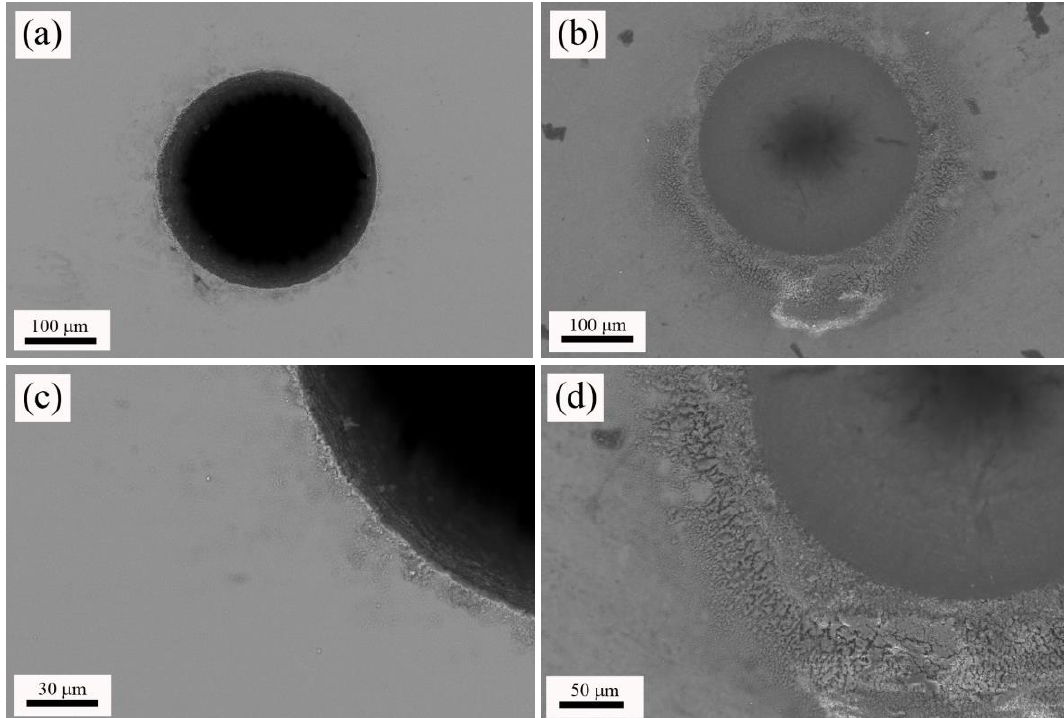
Figure 3. Top-view micrographs of the machined glass ( a ) and glass-ceramic ( b ); and detail of the heat affected zone, HAZ, produced in the surroundings of the processed area in the glass ( c ) and glass-ceramic ( d ). Table 2. EDX compositional analysis in at % of both W-TCP glass and glass-ceramic sample. Sample Si